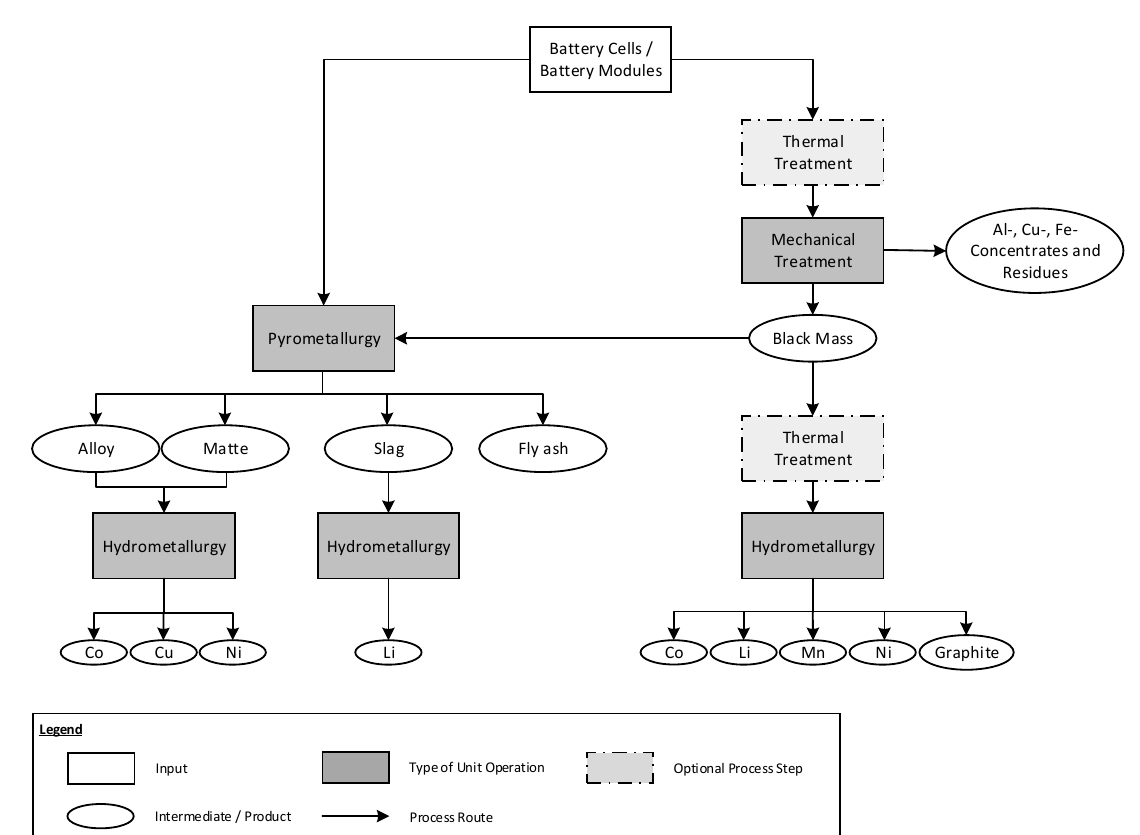
Figure 3. Possible process routes in the recycling of lithium-ion batteries.